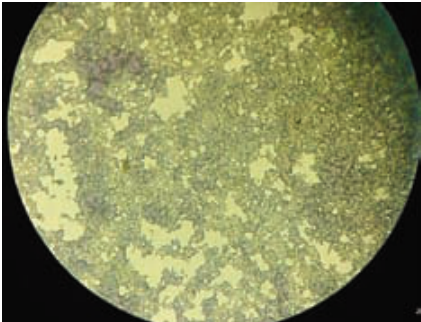
Fig. 4. Budding yeast cells X1000, Giemsa stain